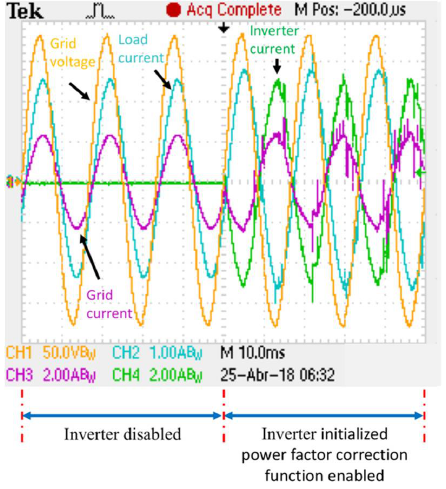
Figure 12. Startup response of the inverter.